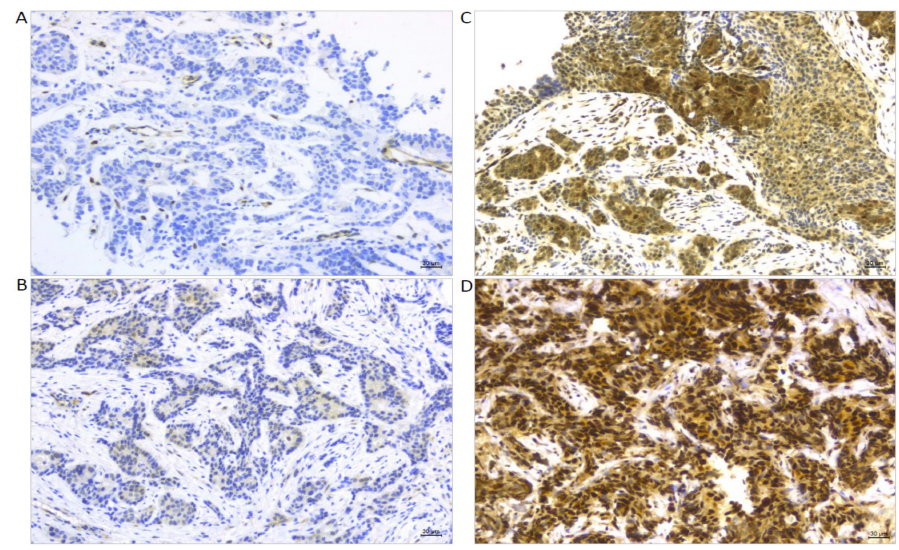
Figure 5. TAZ expression levels in terms of international immunoreactive score categories (SxP_irs_c). ( A ) Tumor from a patient that did not obtain pCR, showing “negative” nuclear and cytoplasmic expression. ( B ) Tumor from a patient that did not obtain pCR, showing “positive weak” nuclear and cytoplasmic expression. ( C ) Tumor from a patient that obtained pCR, showing “positive intermediate” nuclear and cytoplasmic expression. ( D ) Tumor from a patient that obtained pCR, showing “positive strong” nuclear and “positive intermediate” cytoplasmic